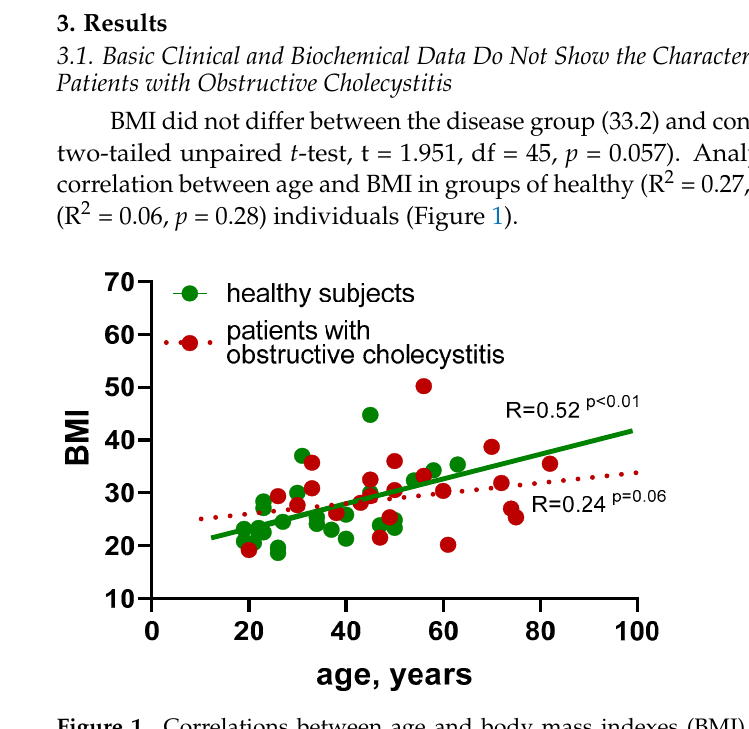
Figure 1. Correlations between age and body mass indexes (BMI) in patients with obstructive cholecystitis and in healthy subjects.